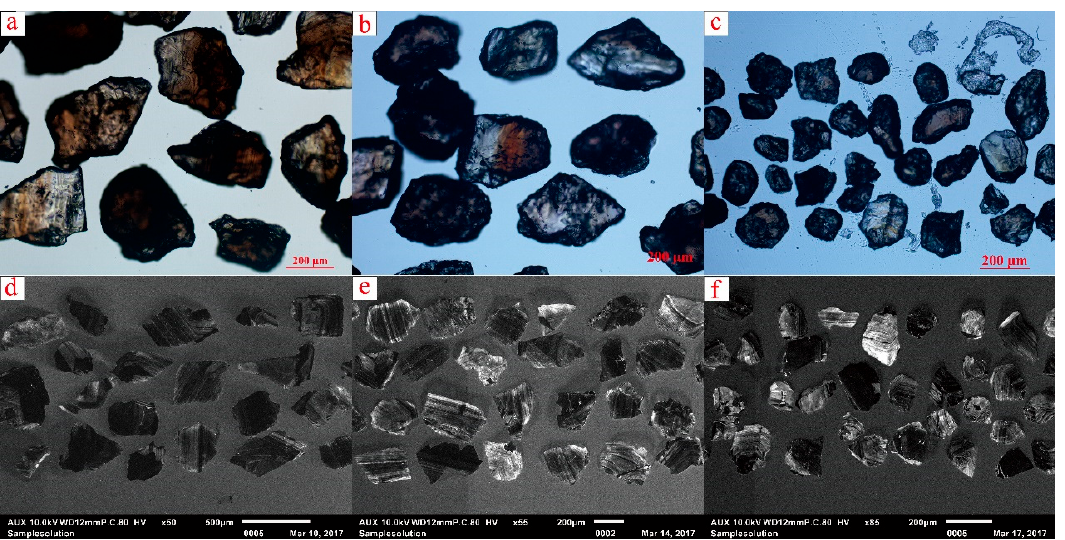
Figure 4. Photomicrographs and cathodoluminescence (CL) image of tin ores from the Xi’ao Cu-Sn deposit. XA-3: ( a , d ); XA-4: ( b , e ); XA-5: ( c , f ). Pronounced differences in the luminescence and internal structures of CL images were observed among cassiterites that formed in different crystallization environments (Figure 5). Based on the luminescence and complexity of the internal structures observed in CL images, the cassiterites could be divided into two zones: (1) the H zone (homogeneous zone), which is characterized by black luminescence and homogeneous internal structures (Figure 5a,b,d), and (2) the O zone (oscillatory zone), which exhibits gray, off-white luminescence with some hourglass structures and oscillatory zoning (Figure 5a,b) and others homogeneous (Figure 5c,e). XA-3 cassiterites had both H and O units, and oscillatory zoning was common in O units. XA-4 cassiterites were predominantly composed of O